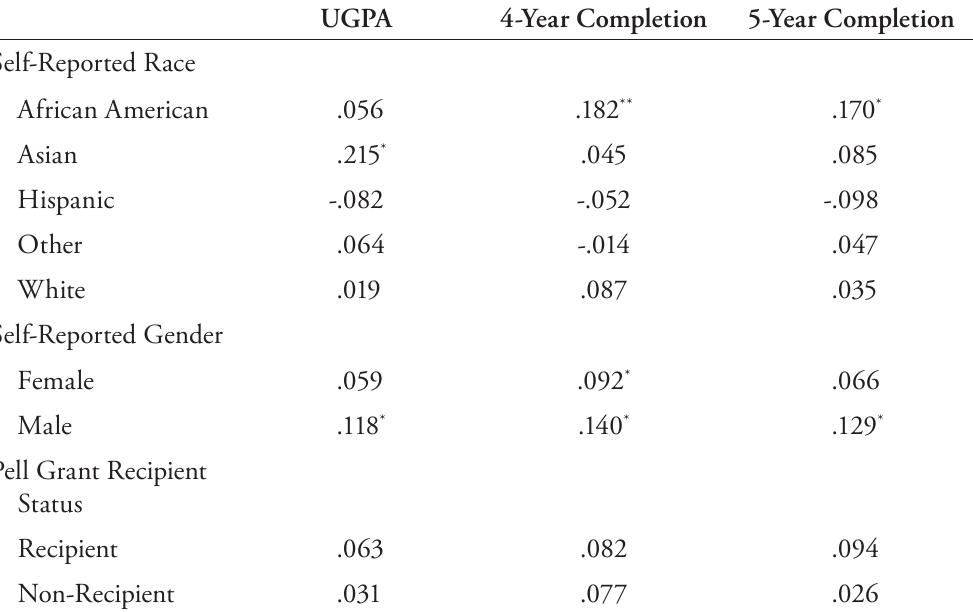
Table 4. Correlations between Attributions Score and Outcome Variables by Applicants’ Demographic